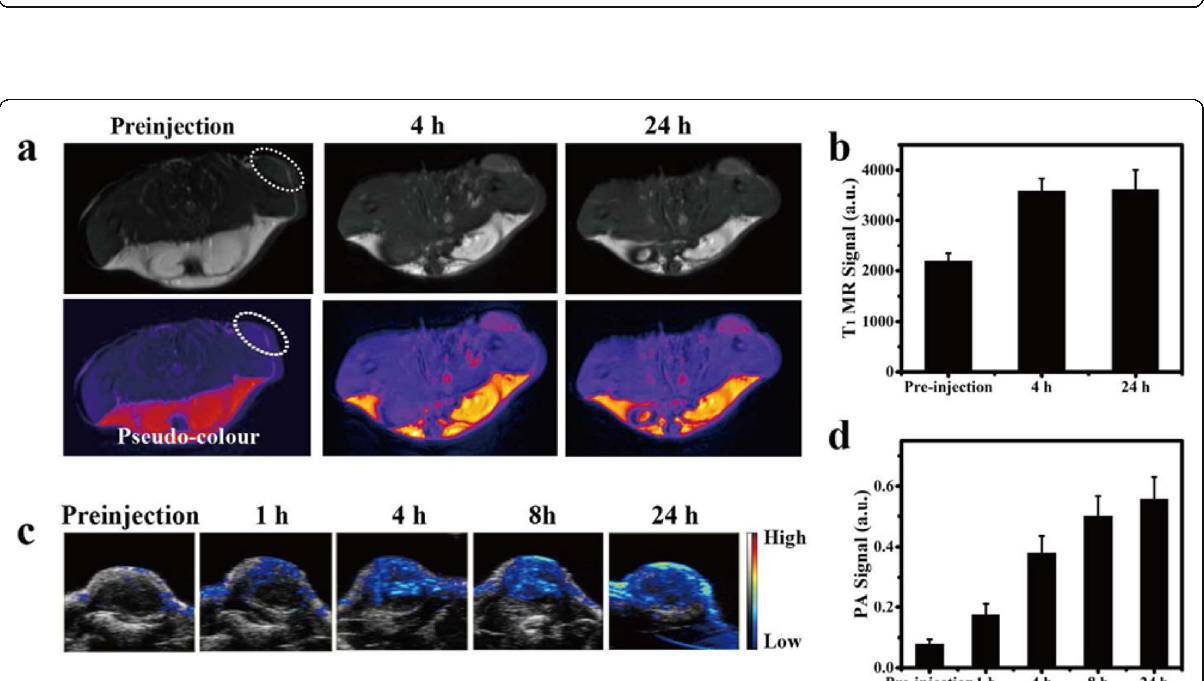
Fig. 5 Preparation of dual-responsive AuNNP@SN 38 Ve loaded with BLZ-945. The smaller AuNNP@PEG/PSN 38 VP then penetrated the deeper tumor regions and released the SN 38 prodrug in the reductive environment, leading to tumor cell apoptosis. PA imaging in the NIR-II window further enabled drug release monitoring and guided therapy